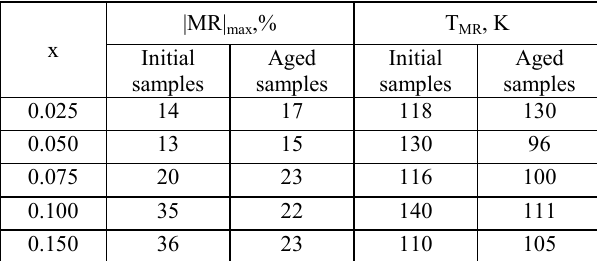
Table 3. Maximal absolute values of magnetoresistance at corresponding temperatures.